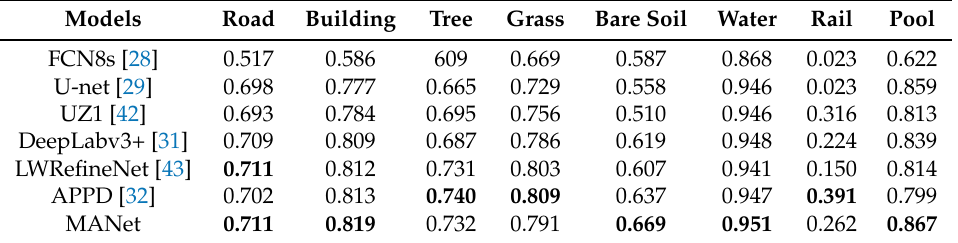
Table 6. The F1 for each category of MANet and six other compared algorithms on the Zurich dataset. Models Road Building Tree Grass Bare Soil